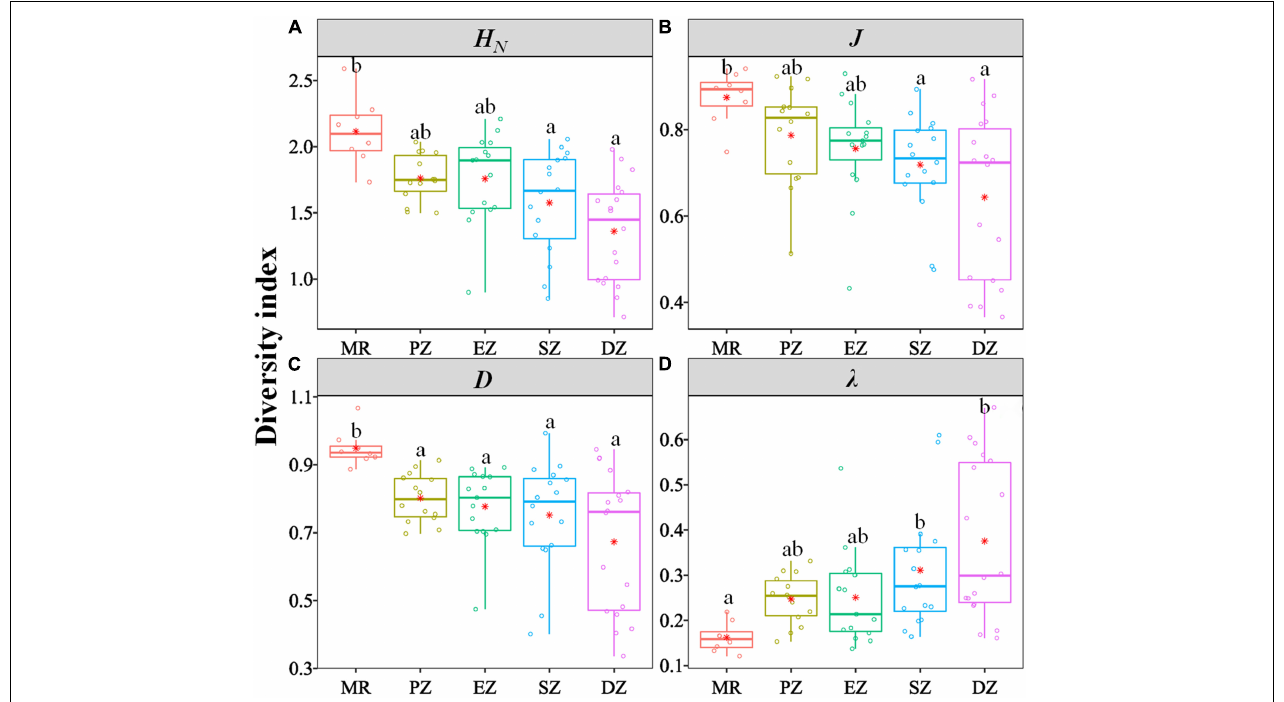
FIGURE 3 | Box and whisker plots characterizing the distribution of different indices [ (A) Shannon–Wiener diversity index H N , (B) Pielou evenness index J , (C) Simpson diversity index D , (D) Simpson dominance index λ ] characterizing the biodiversity of fish communities inhabiting the Mangshe River (MR) and different purification zones of Lake Yanlong (PZ, the pretreatment zone; EZ, the emergent macrophyte zone; SZ, the submerged macrophyte zone; DZ, the deep purification zone). Different letters above bars denote significant differences among zones. Asterisks represent mean values.